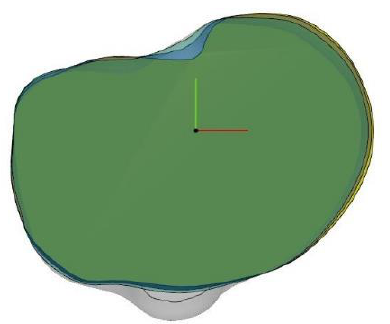
Figure 6. Contour of the tibia plateau cut at 8 (dark green), 10 (blue) and 12 mm (light green).